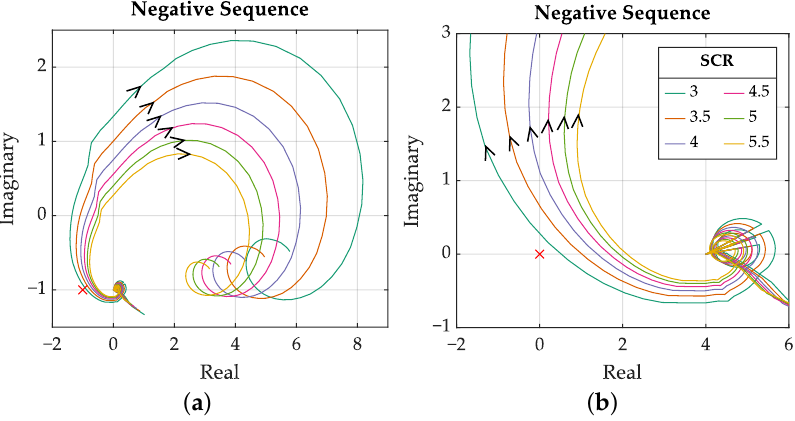
Figure 23. Complete (a) and zoomed (b) Nyquist plots of MMC in grid-following control mode and AC grid with negative-sequence